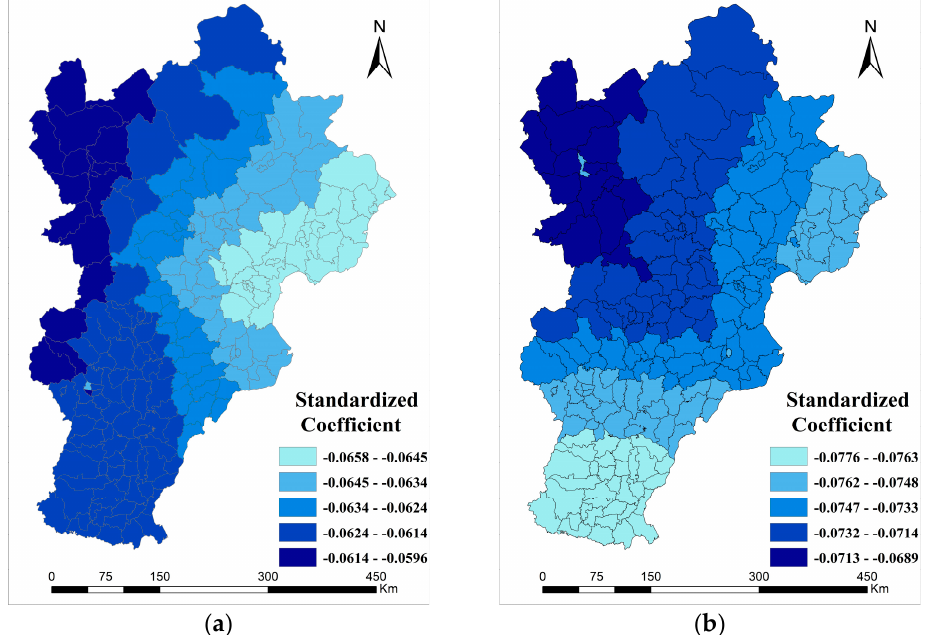
Figure 8. Spatial heterogeneity of the influence of spatial context on carbon storage ( a ): 2010, ( b ): 2018. Table 7. Specific settings of scenario simulations with corresponding carbon storage loss.